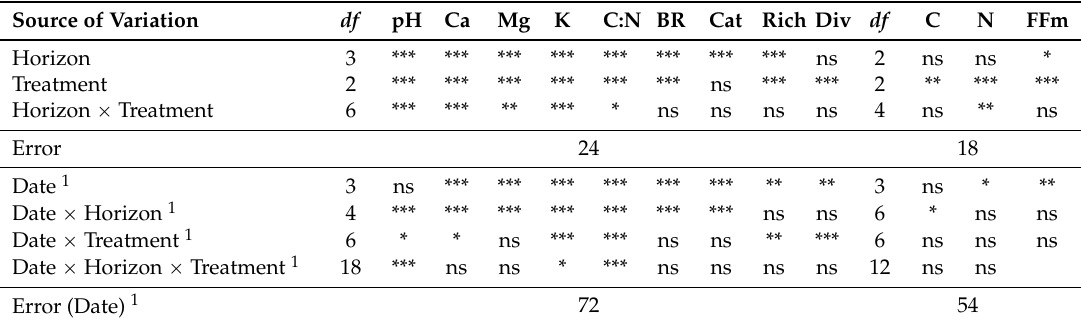
Table 2. Analyses of variance of soil characteristics (significance of F- tests).